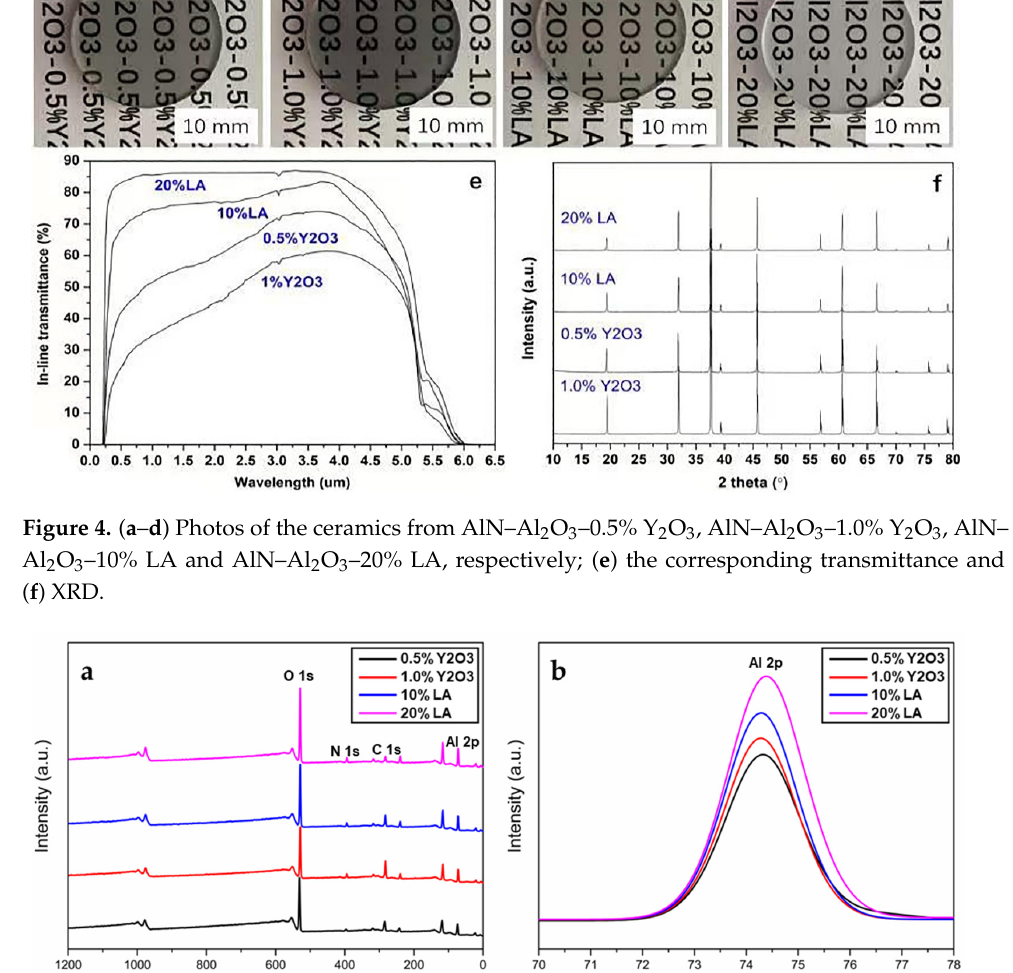
Figure 5. ( a ) XPS spectra of the samples with different dopants and ( b ) high-resolution XPS spectra of Al 2p.